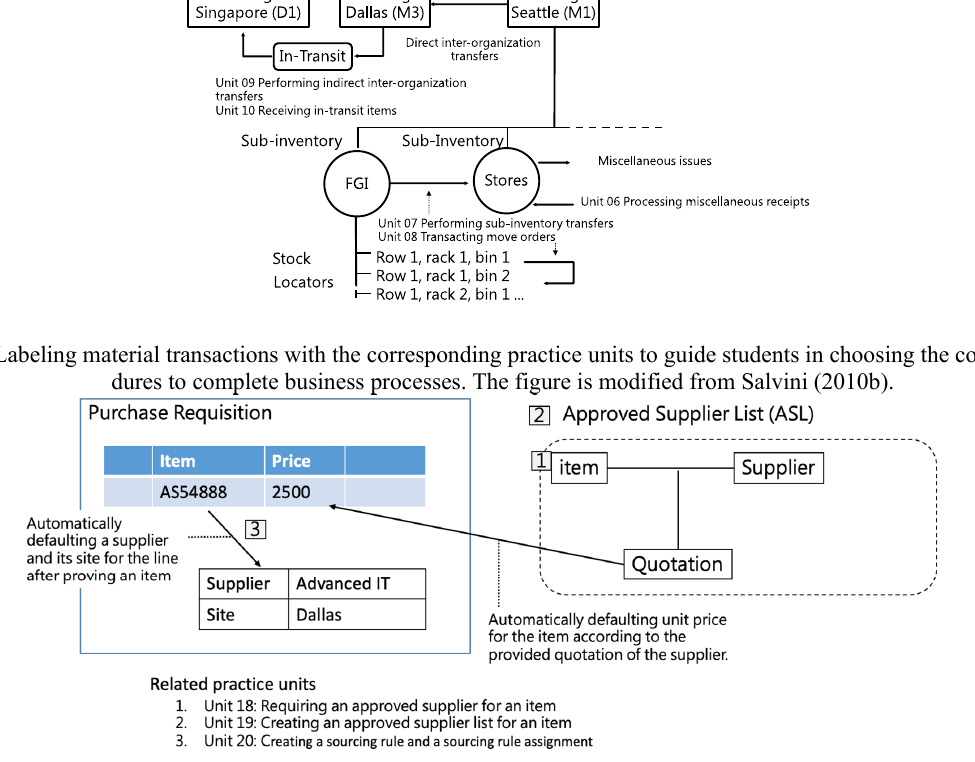
Fig. 2. The configuration procedure of the auto-sourcing function in Oracle EBS ERP is expanded into sequential practice units to assist students in understanding the contextual relationships between these practice units.